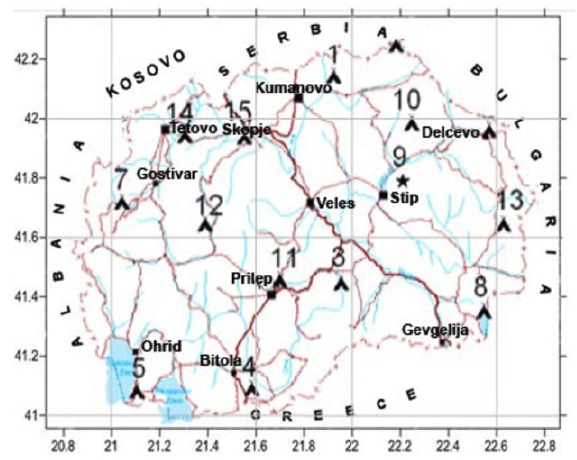
Figure 1. Map of the repeat stations in the Republic of Macedonia.